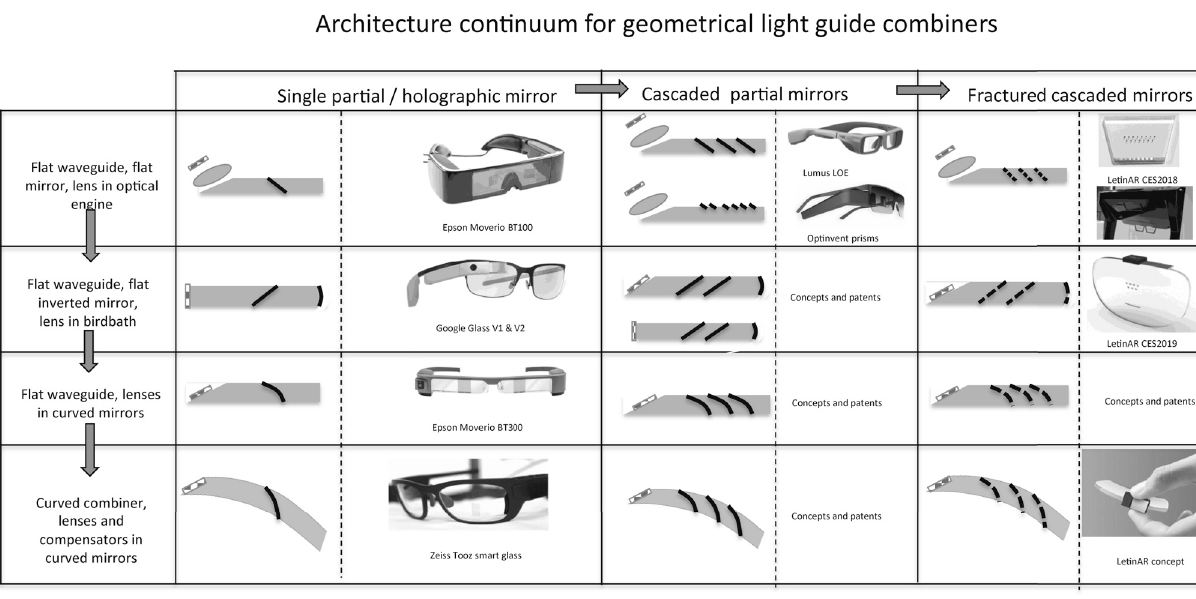
Figure 8: Multiplying or fracturing the extractor mirrors in flat or curved table. Mirrors can be half tone (Google Glass, Epson Moverio),